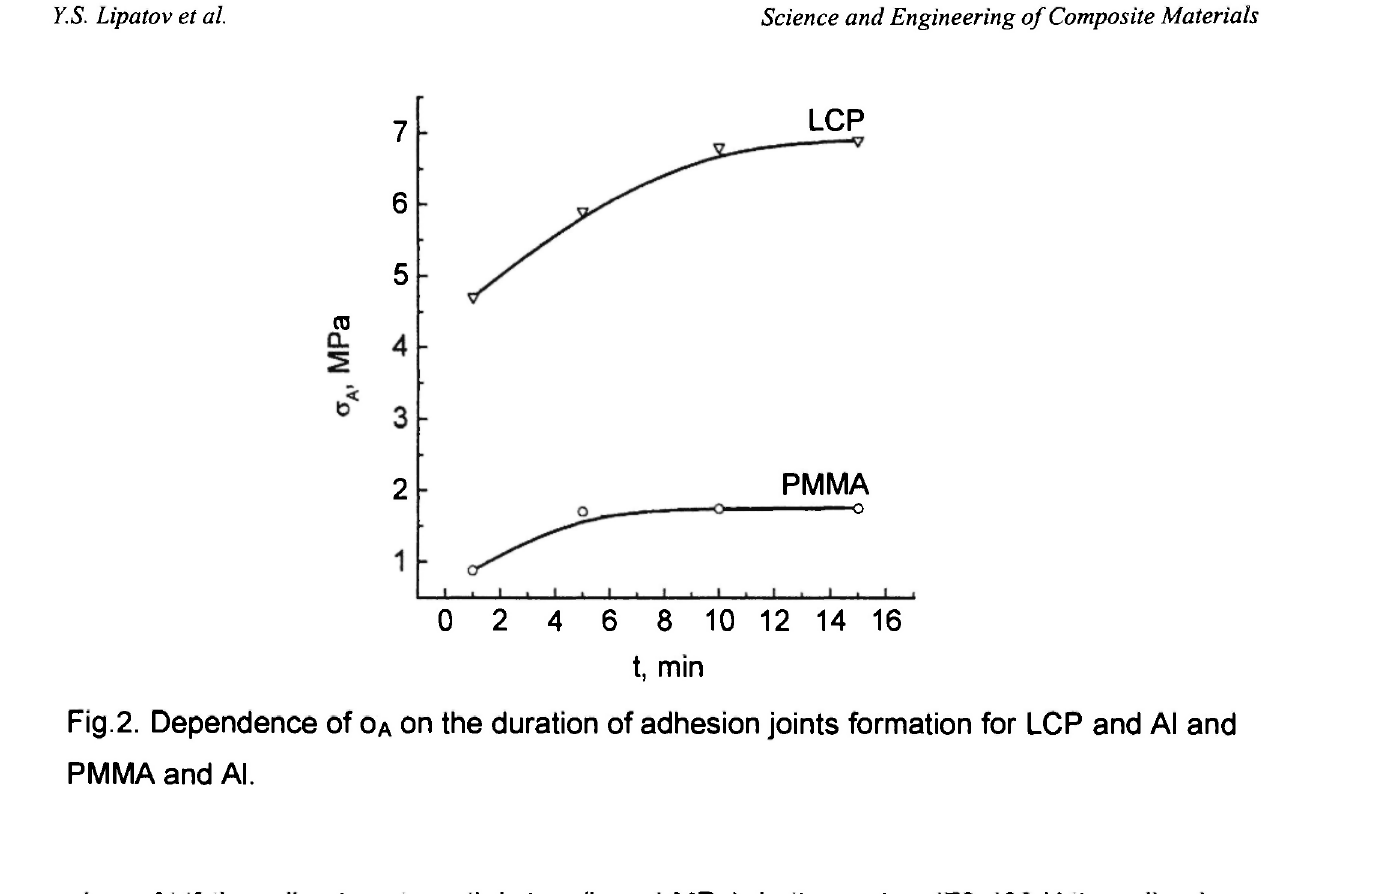
Fig.2. Dependence of oa on the duration of adhesion joints formation for LCP and Al and PMMA and